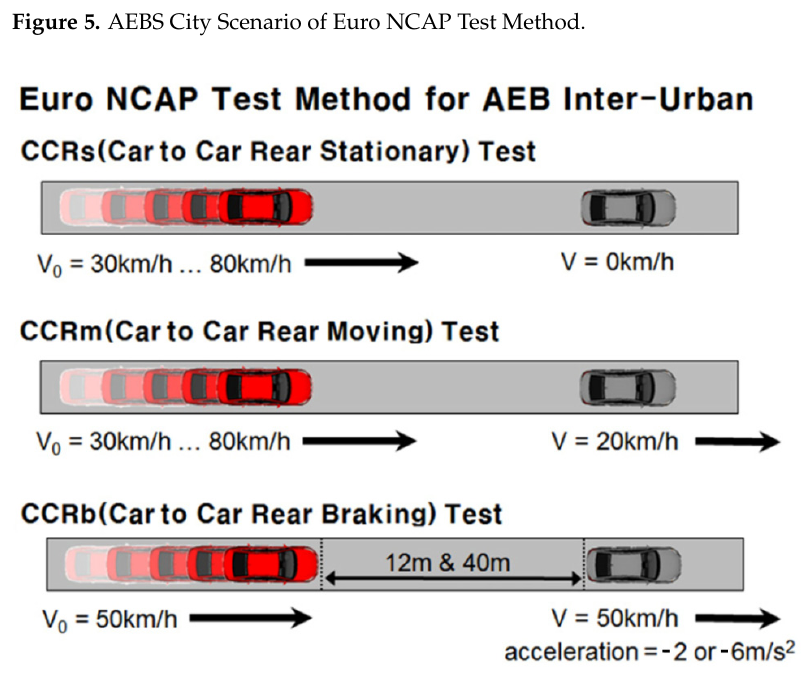
Figure 6. AEBS inter-urban scenario of Euro NCAP (New Car Assessment Program) test method.